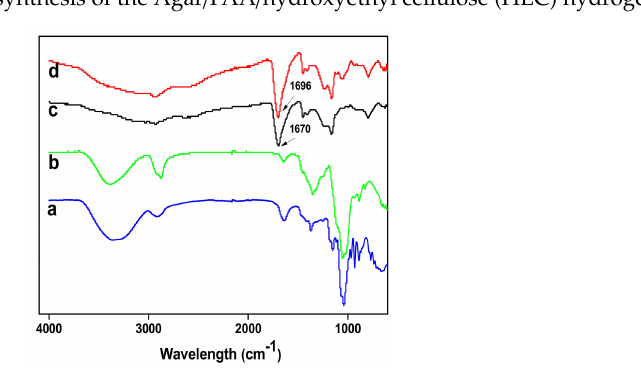
Figure 1. Scheme of the synthesis of the Agar / PAA / hydroxyethyl cellulose (HEC) hydrogels.